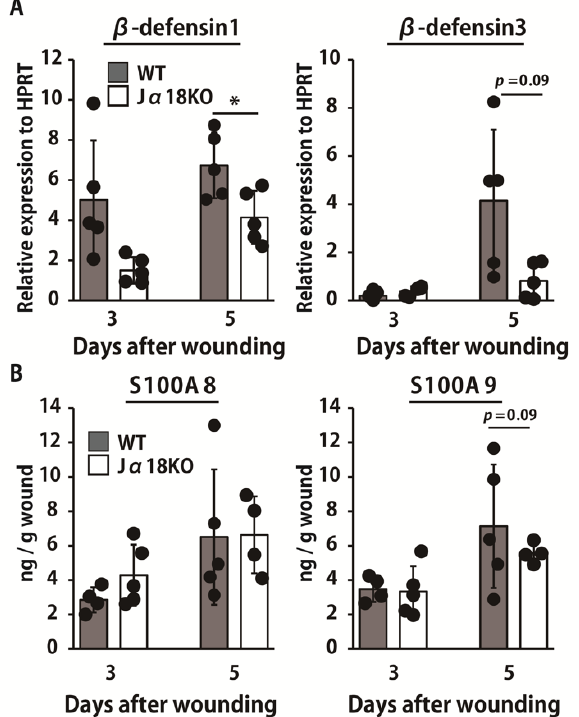
Figure 3. Effect of iNKT cell deficiency on the production of antimicrobial peptides at the wound sites after inoculation with P. aeruginosa . WT and J α 18KO mice were wounded and inoculated with P. aeruginosa . ( A ) Expression of β -defensin1 and β -defensin3 in the wounded tissues was measured on days 3 and 5 (n = 4–5). ( B ) Production of S100A8 and S100A9 in the wound tissue homogenates were measured at each specified point (n = 4–5). Black circles represent one individual mouse. Each column represents the means ± SD. The results are representative of at least two independent experiments. * p < 0.05.